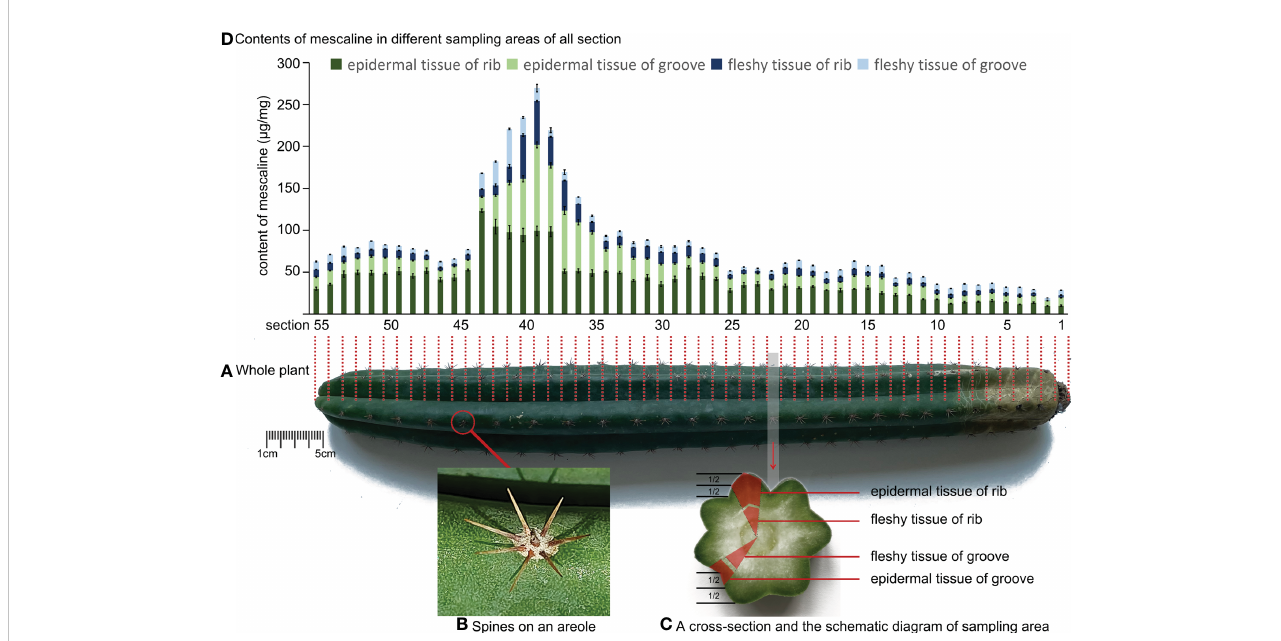
FIGURE 1 (A) Schematic diagram of the position of the longitudinal incision of Trichocereus pachanoi . (B) Spines on an areole of Trichocereus pachanoi . (C) A cross-section and the schematic diagram of sampling area of Trichocereus pachanoi . (D) Mescaline content in different sampling areas of all sections of Trichocereus pachanoi